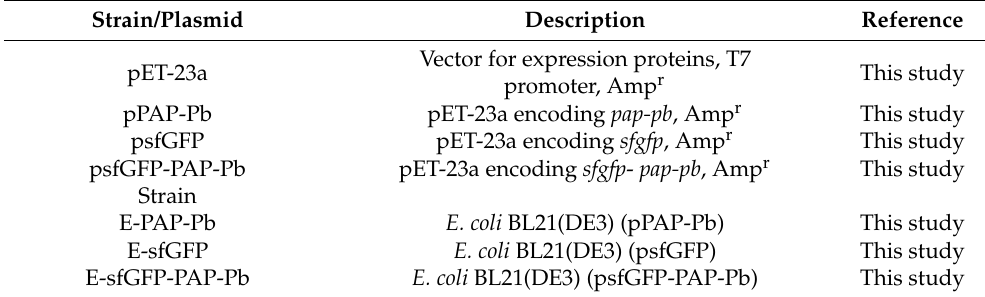
Figure 2. Construction of recombinant plasmids for the cell surface display of PAP-Pb. T7 Pro: T7 promoter; T7 Ter: T7 terminator. Table 2. Plasmids and strains used in this